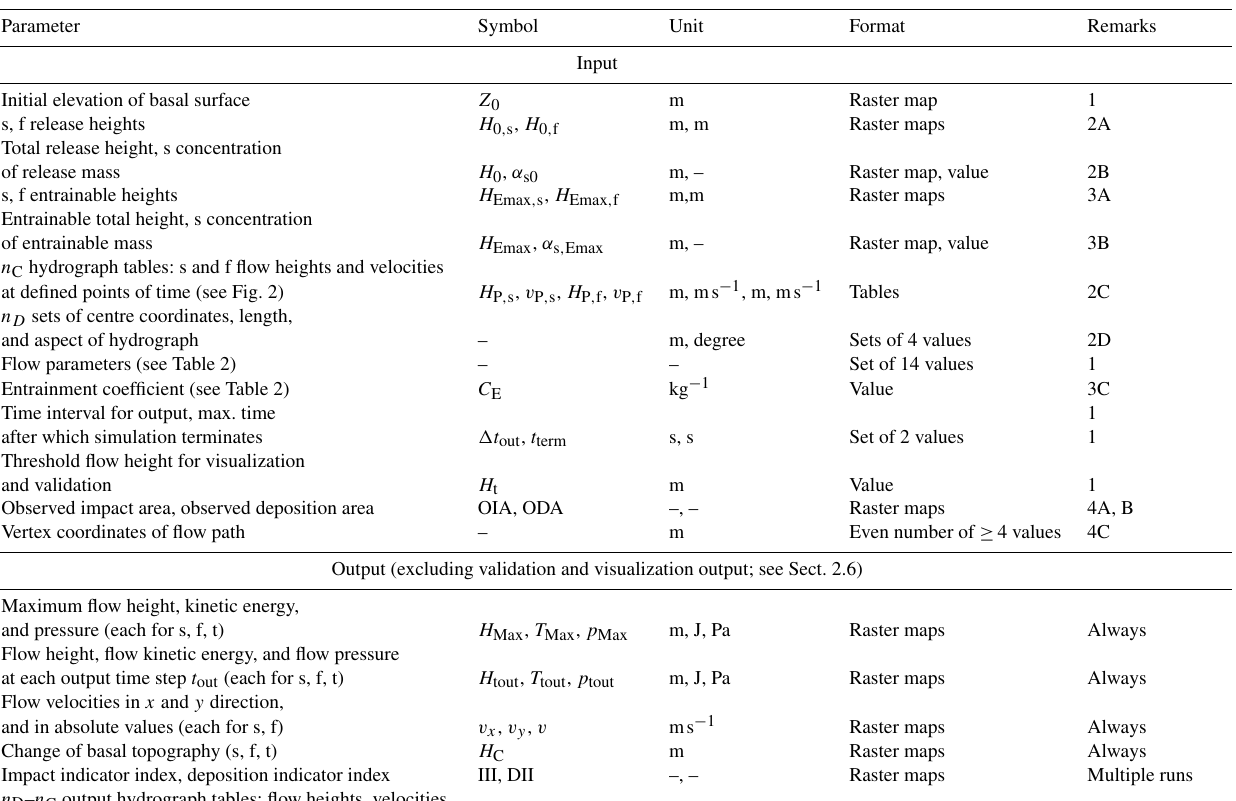
Table 1. Key input and output parameters of r.avaflow – s: solid; f: fluid; t: total. Remarks: 1: mandatory; 2: one of the input data sets A, B, or C + D is mandatory, C + D may also be provided in addition to A or B; n D ≥ n C , if n D > n C the remaining sets of D are output hydrographs; 3: either A or B may be provided if entrainment is activated, otherwise all values of H Emax = ∞ ; C is mandatory with entrainment; 4: at least one of the data sets A, B, and C is mandatory for validation.